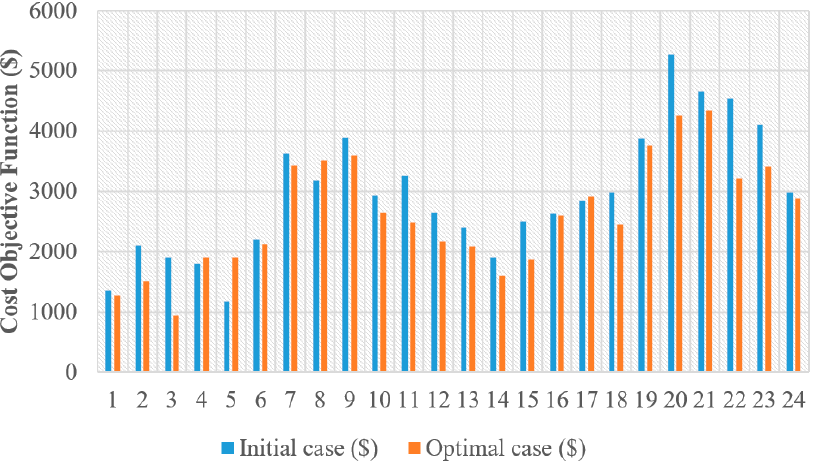
Figure 10. Hourly cost of the microgrid before and after optimal switching operation.